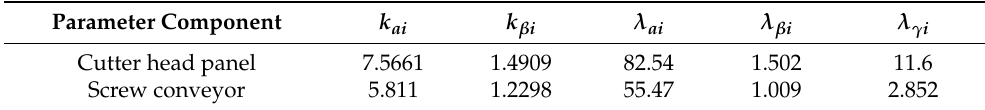
Table 8. Shape and scale parameters for the cutter head panel and screw conveyor under the Weibull distribution.